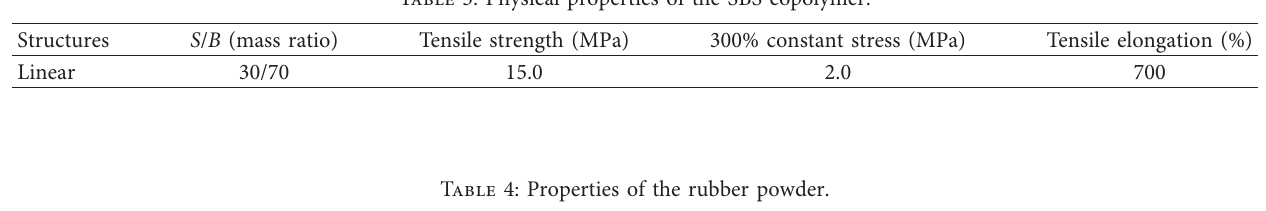
Table 3: Physical properties of the SBS copolymer.